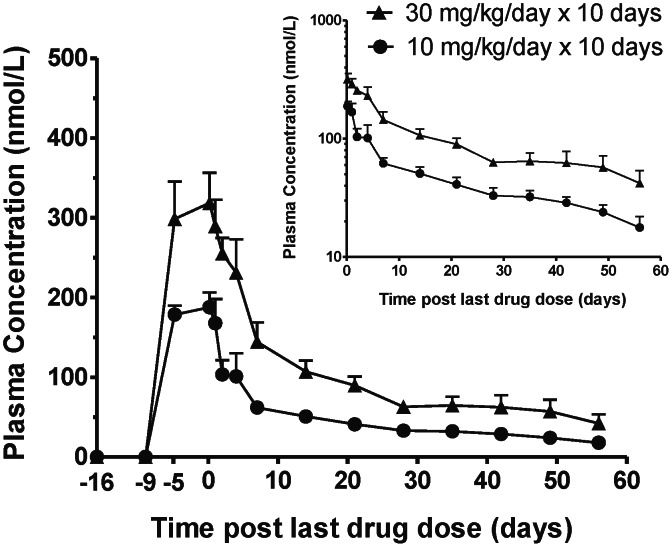
Plasma concentration-time profiles of DB829 following administration of the prodrug DB868 to uninfected vervet monkeys.DB868 was administered orally at 10 mg/kg/day (n = 4) or 30 mg/kg/day (n = 4) for 10 days, day −9 to day 0 post-last drug dose. Symbols and error bars represent geometric means and SEs of the active compound DB829 concentrations, respectively. The inset graph shows the plasma concentration-time profiles starting at day 0 post-last drug dose on a logarithmic scale.